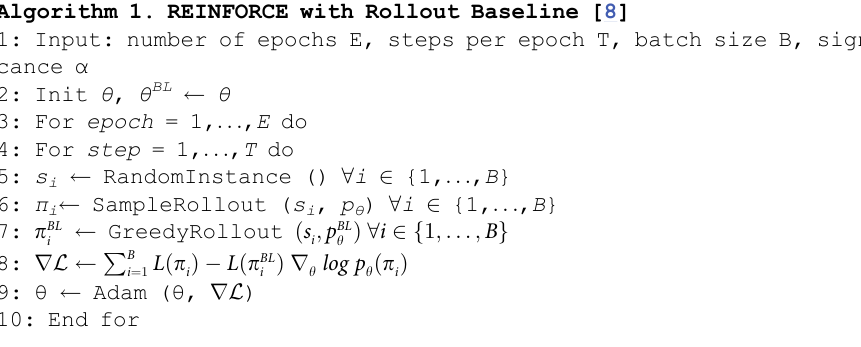
Algorithm 1. REINFORCE with Rollout Baseline [8]